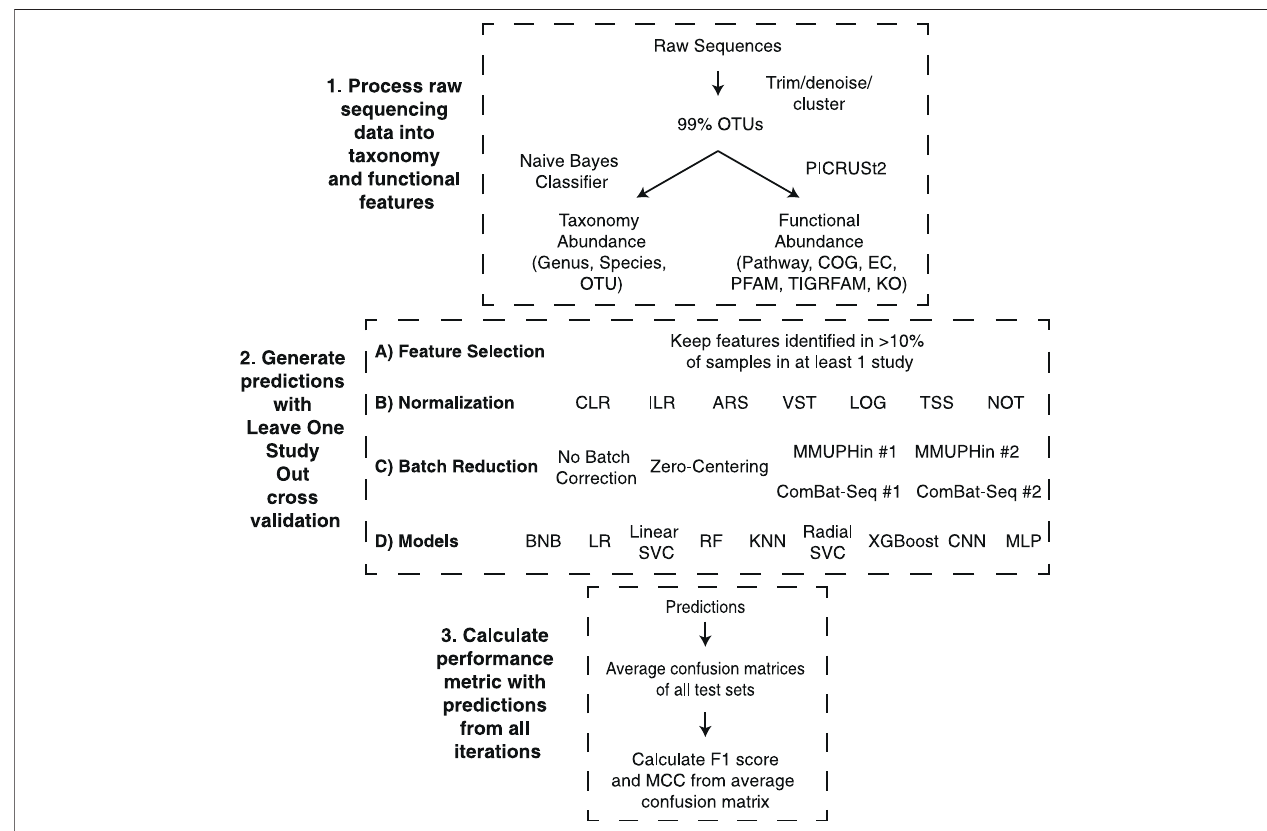
FIGURE 1 | Leave-one-dataset-out cross-validation pipeline. The experiments comprised three different stages to go from raw sequence fi les to the performance metrics. 1) Raw sequences were processed with Dada2 or Deblur and close-reference clustered into OTUs at 99% identity. The OTUs were classi fi ed to taxonomy at 99% con fi dence with a Naive Bayes classi fi er and used to infer functional pro fi les with PICRUSt2. 2) Generating predictions for the 15 iterations of our LODO cross validation consisted of all possible combinations of the listed feature selection method, normalization or transformation methods, batch effect correction methods, and models. 3) The average confusion matrix proportions across each iteration was used to generate the overall confusion matrix. The F1 Score and MCC were calculatedusingtheproportionsfromtheaverageconfusionmatrix.Thedescriptionsofacronymsandabbreviationsarethefollowing:ClustersofOrthologousGroupsof proteins (COG), Kyoto Encyclopedia of Genes and Genomes (KEGG) orthologs (KO), Enzyme Commission (EC), Pfam protein domain (PFAM), TIGR protein family (TIGRFAM) and MetaCyc pathways (pathway), centered log-ratio (CLR), isometric log-ratio (ILR), arcsine square root transformation (ARS), variance stabilizing transformation (VST), log transformation (LOG), total sum scaling (TSS), no normalization (NOT), Bernoulli Naive Bayes (BNB), logistic regression (LR), linear support vector machine (Linear SVC), random forest (RF), K nearest neighbours (KNN), radial support vector machine (Radial SVC), eXtreme Gradient Boosting (XGBoost), convolutional neural network (CNN), multilayer perceptron